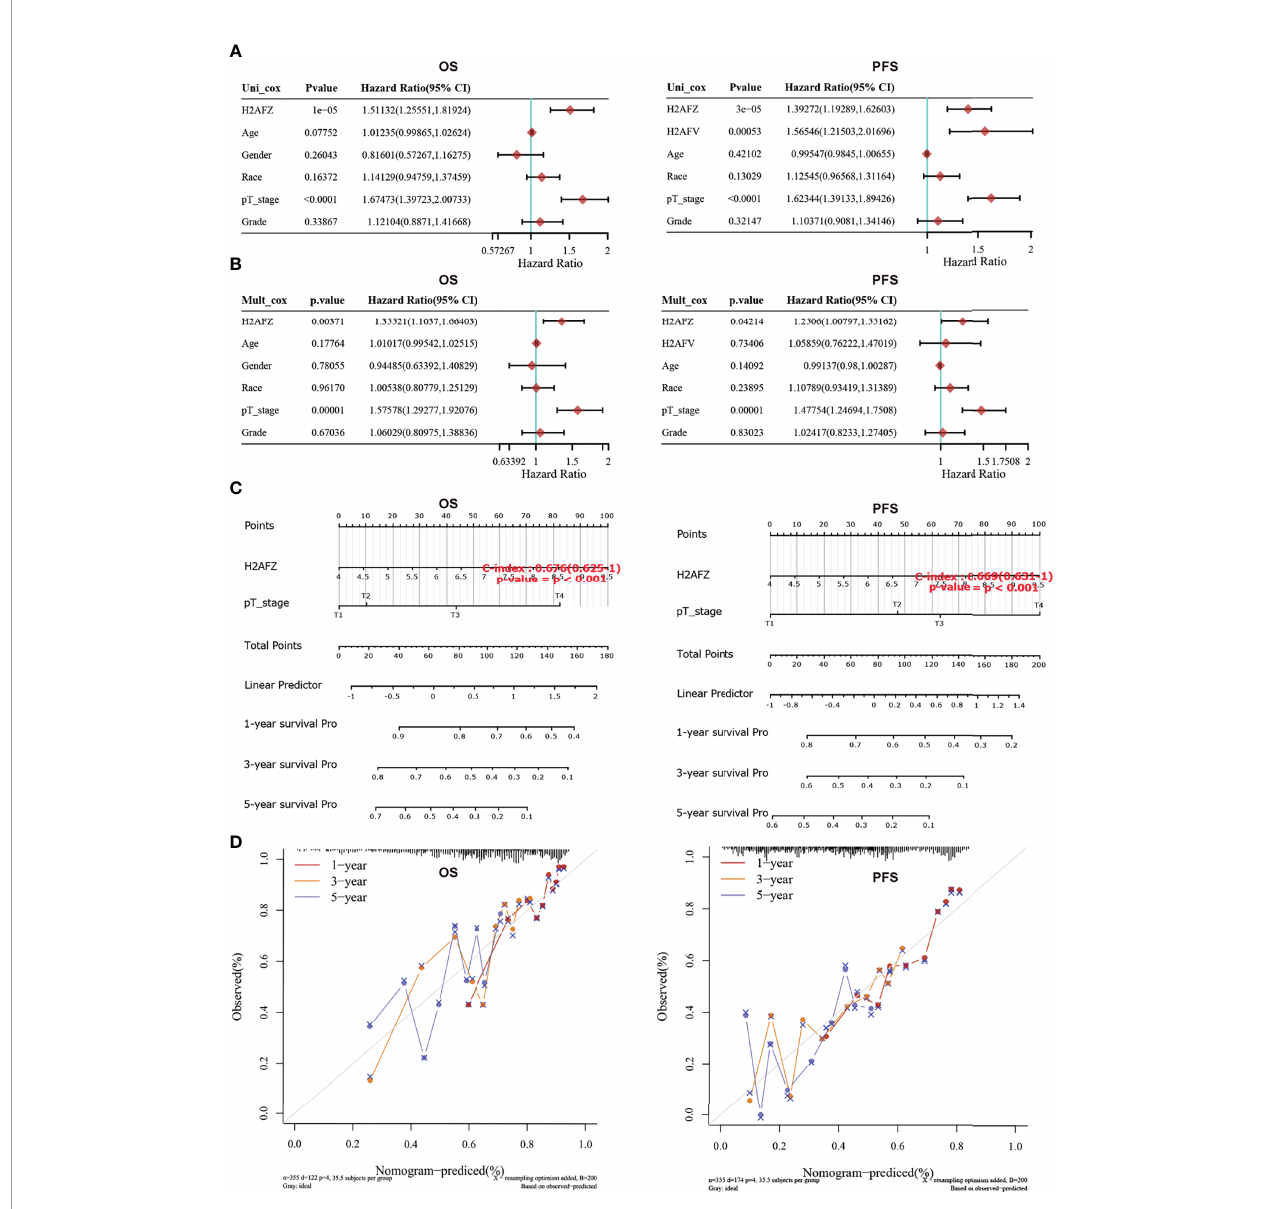
FIGURE 4 | Construction and validation of the nomogram model. (A) Hazard ratios and p -values of constituents involved in univariate Cox regression. (B) Hazard ratios and p -values of constituents involved in multivariate Cox regression. (C) Nomograms to predict the 1-year, 2-year, and 3-year overall survival and progression- free survival of HCC patients. (D) Calibration curves for the overall survival nomogram model and the progression-free survival